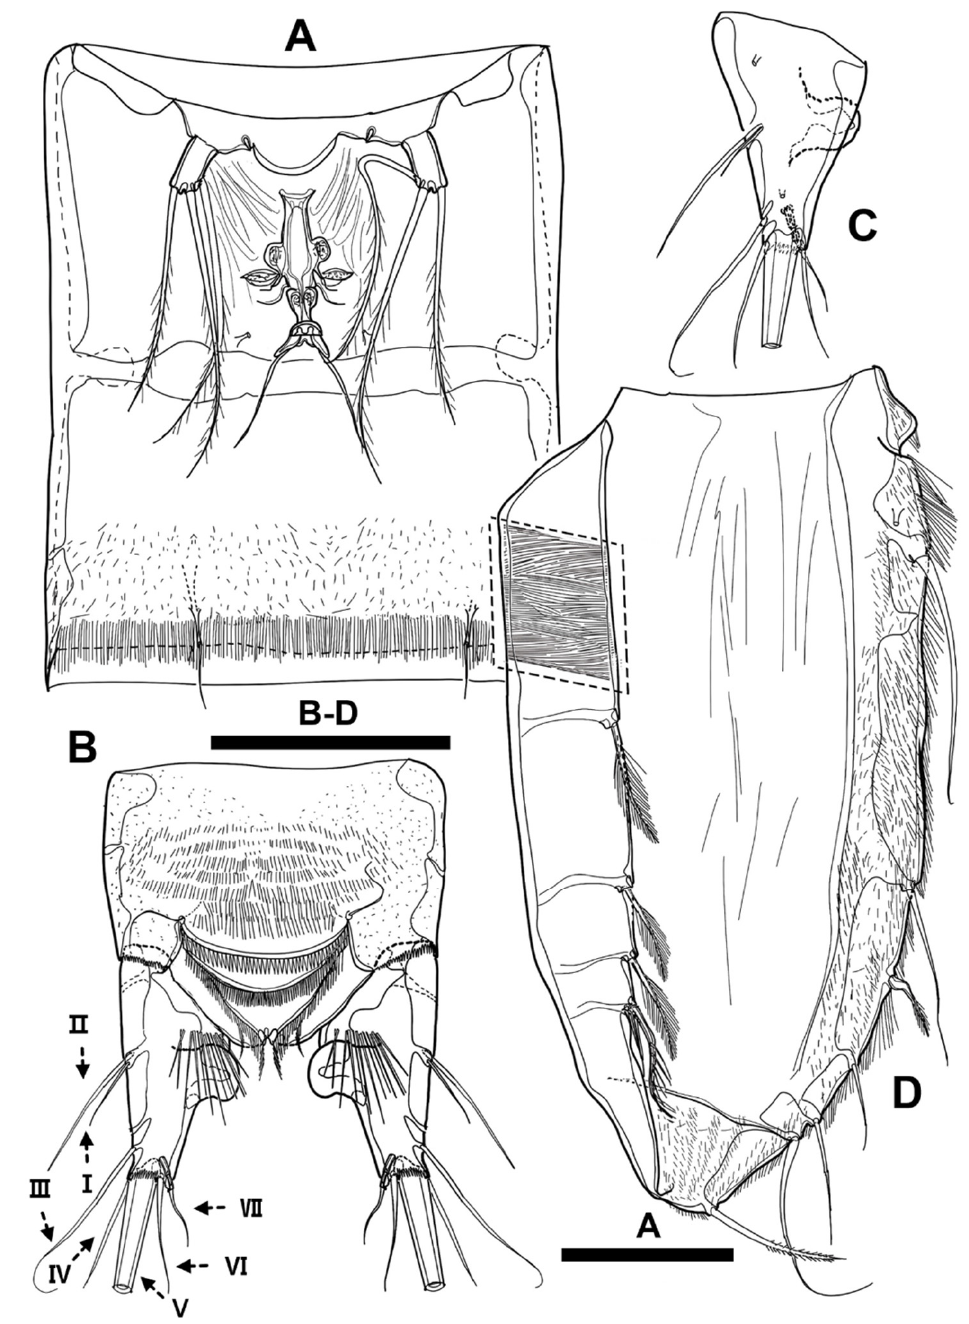
Figure 26. Line drawings of Phyllopodopsyllus similis sp. nov. female (holotype): ( A ) genital double- somite, ventral; ( B ) anal somite and caudal rami, dorsal; ( C ) caudal ramus, ventral; ( D ) P5. Scale bars: 50 µm.